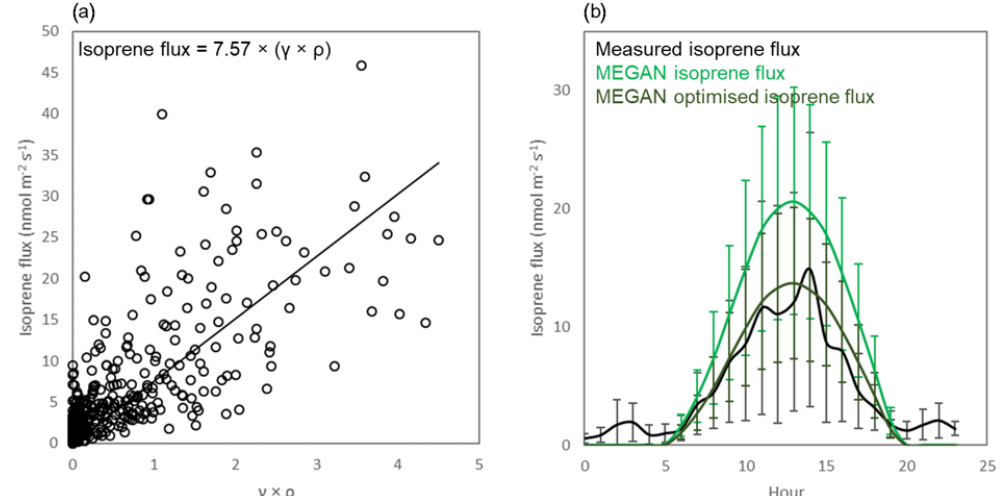
Figure 9. (a) Measured isoprene flux plotted against the product of the emission activity factor ( γ ) and the canopy loss and production factor ( ρ ). (b) Diurnal profiles of the isoprene flux predicted by MEGAN using the default and optimised emission factors together with the measured isoprene flux. Error bars represent standard deviation across the measurement period.